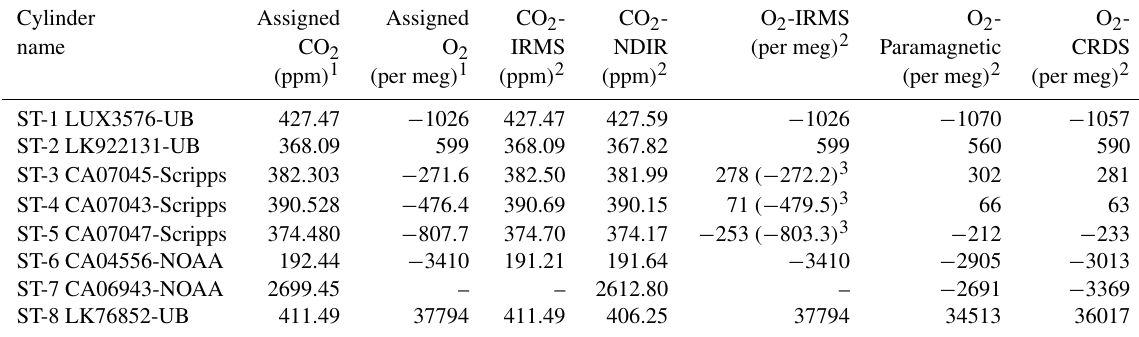
Table 1. Assigned mixing ratios of standard gases used in this study and their corresponding values measured by the NDIR, CRDS, and IRMS at the University of Bern. Cylinder